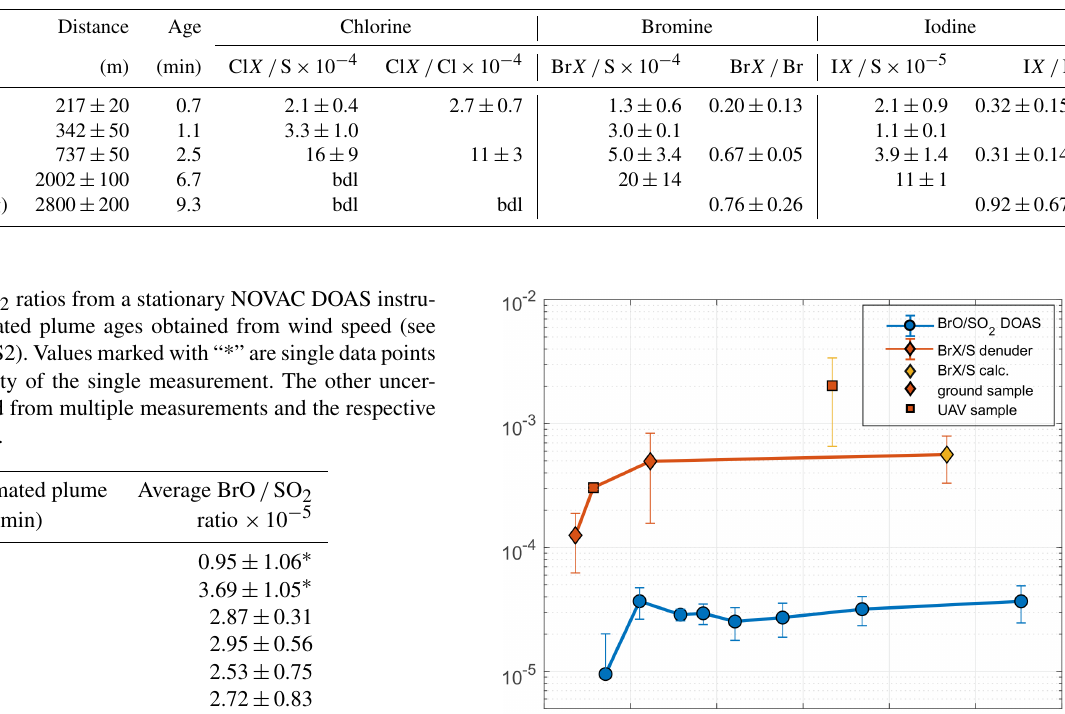
Table 6. RHS/sulfur and total halogen ratios at five different locations and estimated plume ages at 5ms − 1 wind speed (median values). “bdl” denotes that the concentration was below the detection limit.